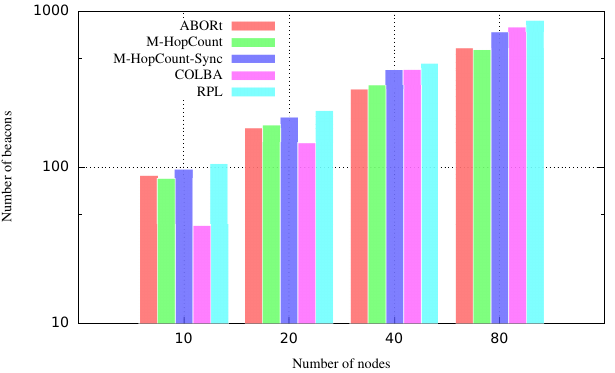
Figure 11. Overhead for 1